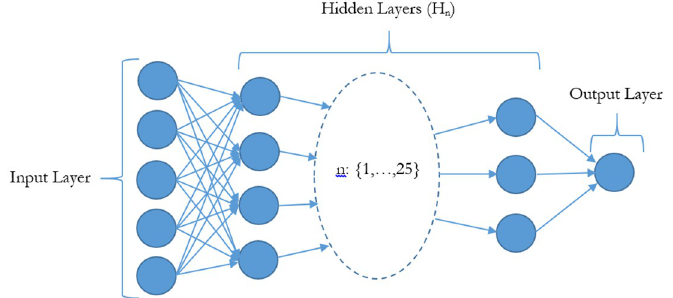
Fig 7. The architecture of the MLP ML model which shows how neurons are interconnected in a “brain-like” synaptic network between input features and output predictions.